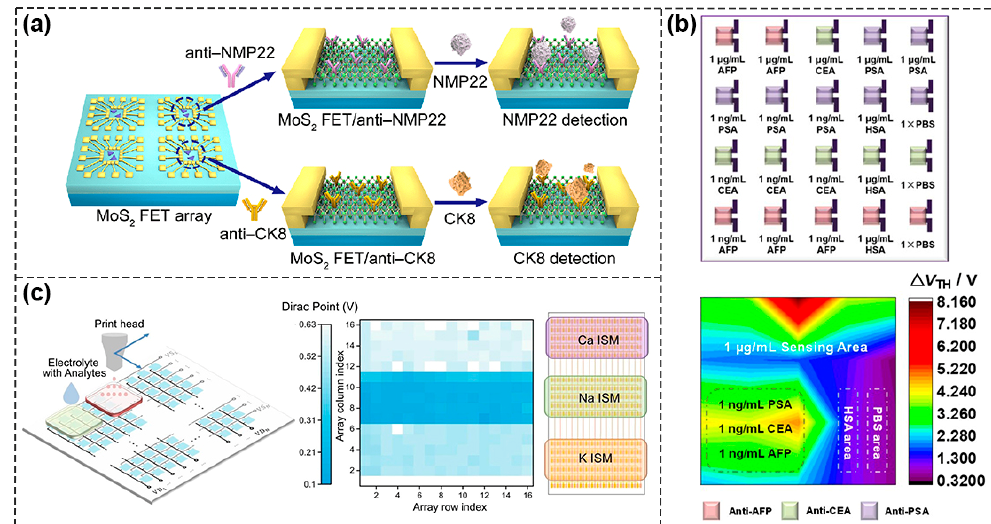
Figure 10. Integration of FET biosensors into array for multiplexing. ( a ) Schematic of FET sensor arrays based on MoS 2 nanosheets for simultaneous detection of multiple bladder cancer biomarkers. Reproduced with permission from [81]. Copyright 2020, Science China Press and Springer − Verlag GmbH Germany, part of Springer Nature.( b ) Simultaneous determination of three biomarkers using a FET sensor array. Reproduced with permission from [82]. Copyright 2022, American Chemical Society.( c ) Diagram of 16 × 16 sensor unit ( left ). Color map of Dirac points for three kinds of ion − sensing unit ( right ). Reproduced with permission from [83]. Copyright 2022, the author(s).